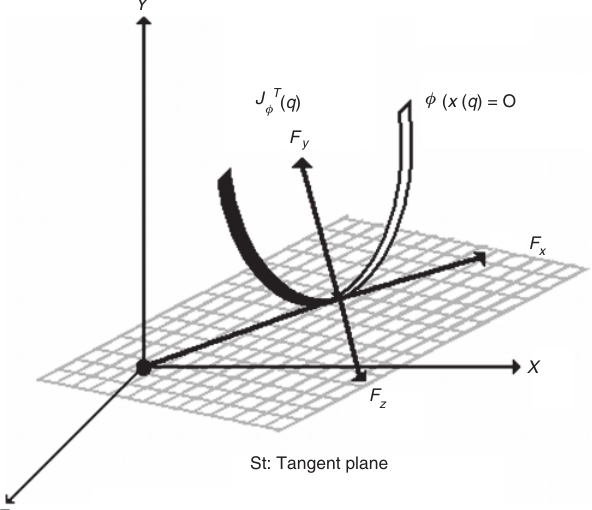
Figure 2 Geometric decomposition in the contact